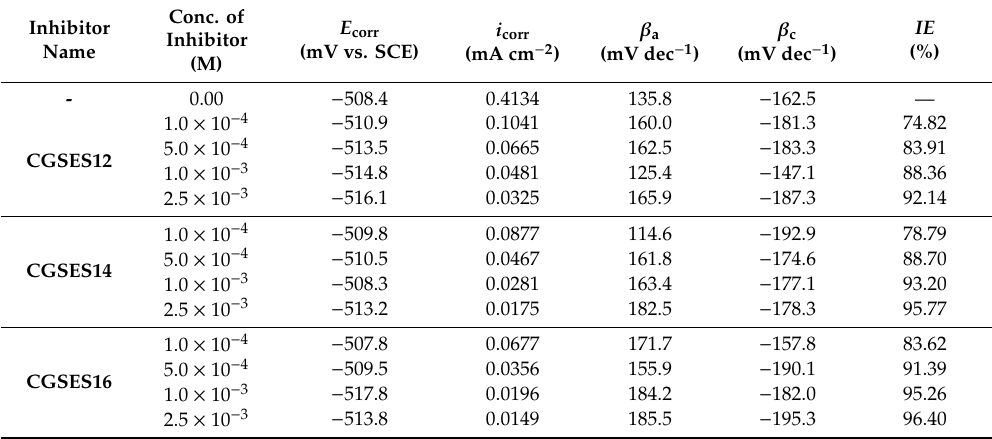
Figure 6. Anodic and cathodic polarization curves for MS obtained at 20 °C in 1 M HCl solution in the absence and presence of different concentrations of CGSES16. Table 4. Potentiodynamic polarization parameters for CS in 1 M HCl with and without di ff erent concentrations of the synthesized cationic gemini surfactants at 20 ◦